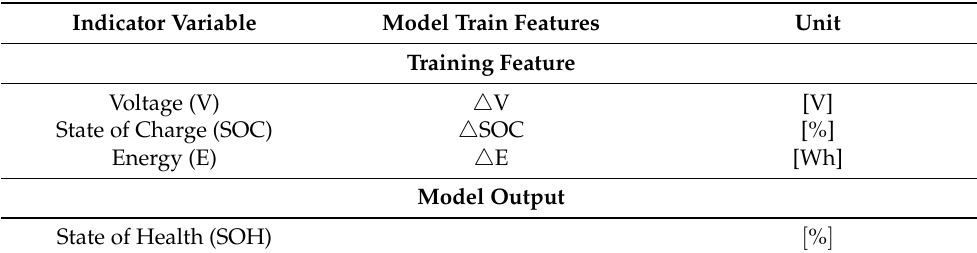
Table 1. Model feature and output variables.